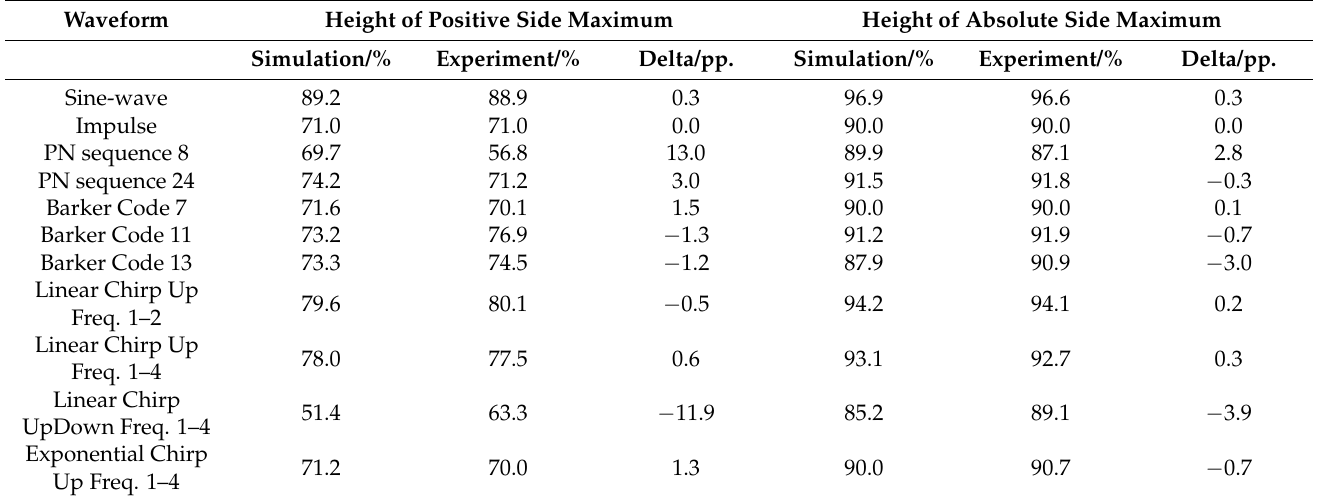
Table 1. Correlation factor magnitude of positive and absolute side maximum comparing results from simulation and experiments. The difference between experiments and simulations is expressed in terms of percentage points (pp). Waveform Height of Positive Side Maximum Height of Absolute Side Maximum Simulation/% Experiment/% Delta/pp. Simulation/% Experiment/%